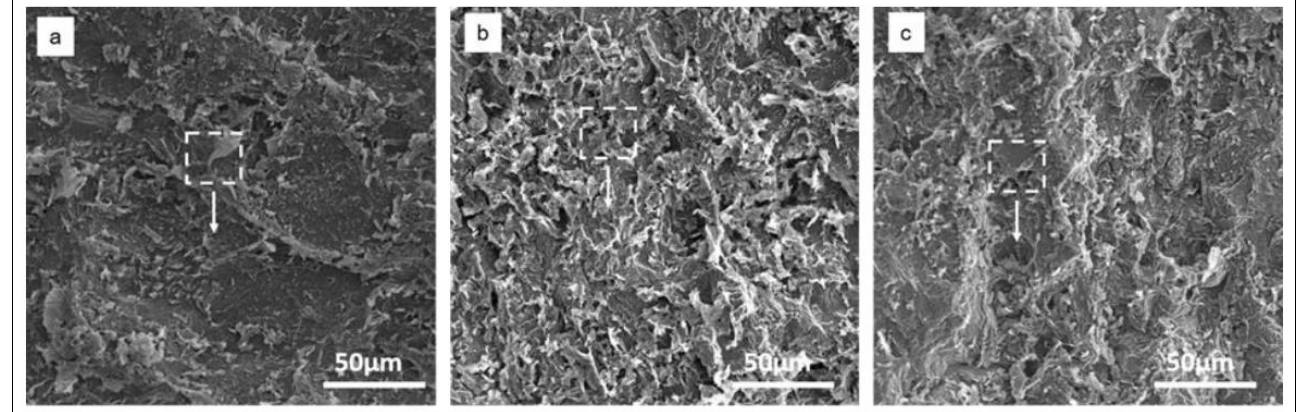
Figure 18. SEM image of metal ( a ) without inhibitor, ( b ) with 400 ppm of Equisetum hyemale extract, and ( c ) with 1000 ppm of Equisetum hyemale extract. Reprinted from [78].